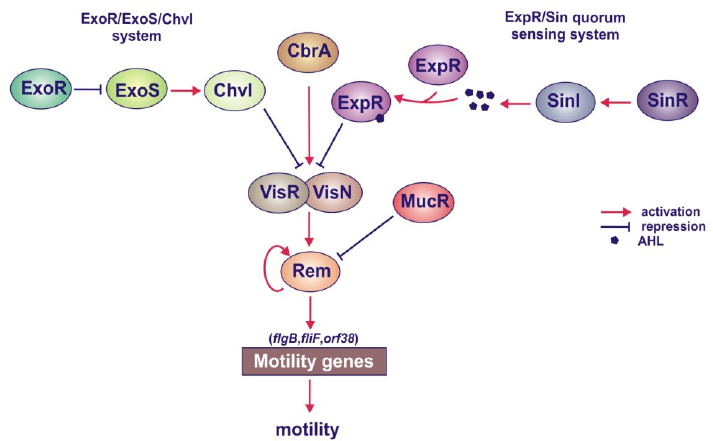
Figure 4. The regulation of S. meliloti motility genes by MucR, CbrA and two ExoR/ExoS/ChvI and ExpR/SinR/SinI regulatory